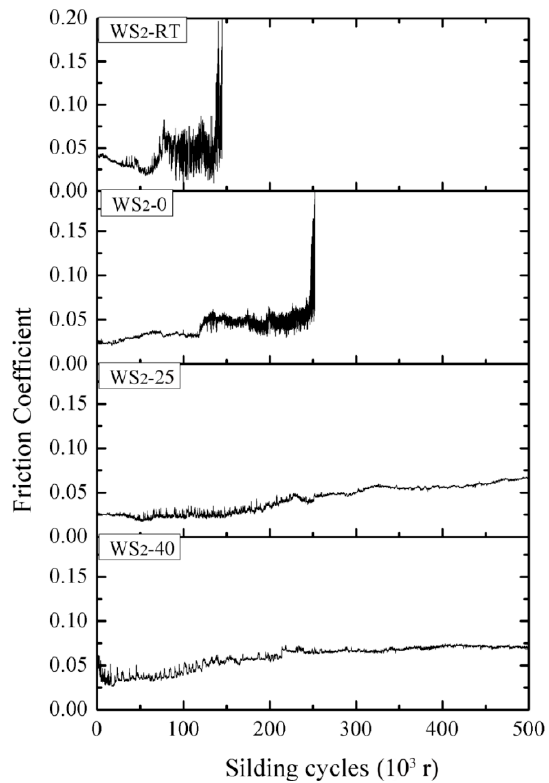
Figure 5. Typical friction curves of the WS 2 films deposited at different substrate temperatures.